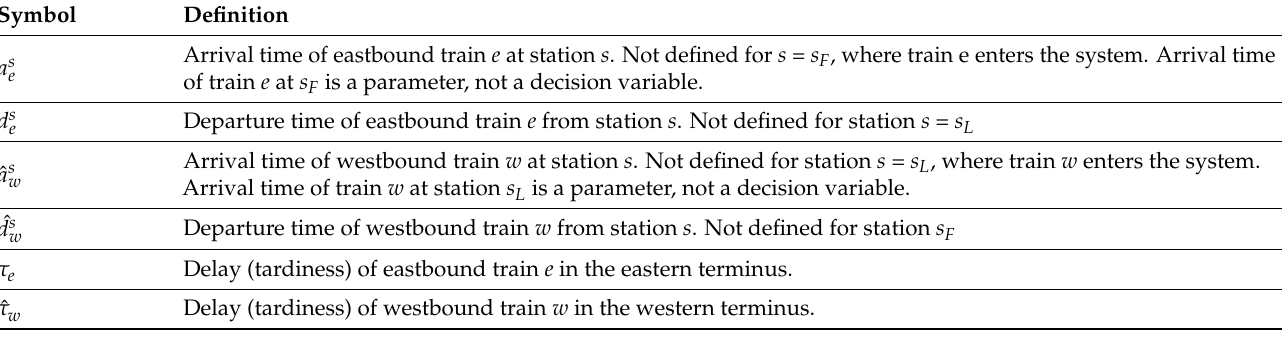
Table 4. Continuous decision variables.